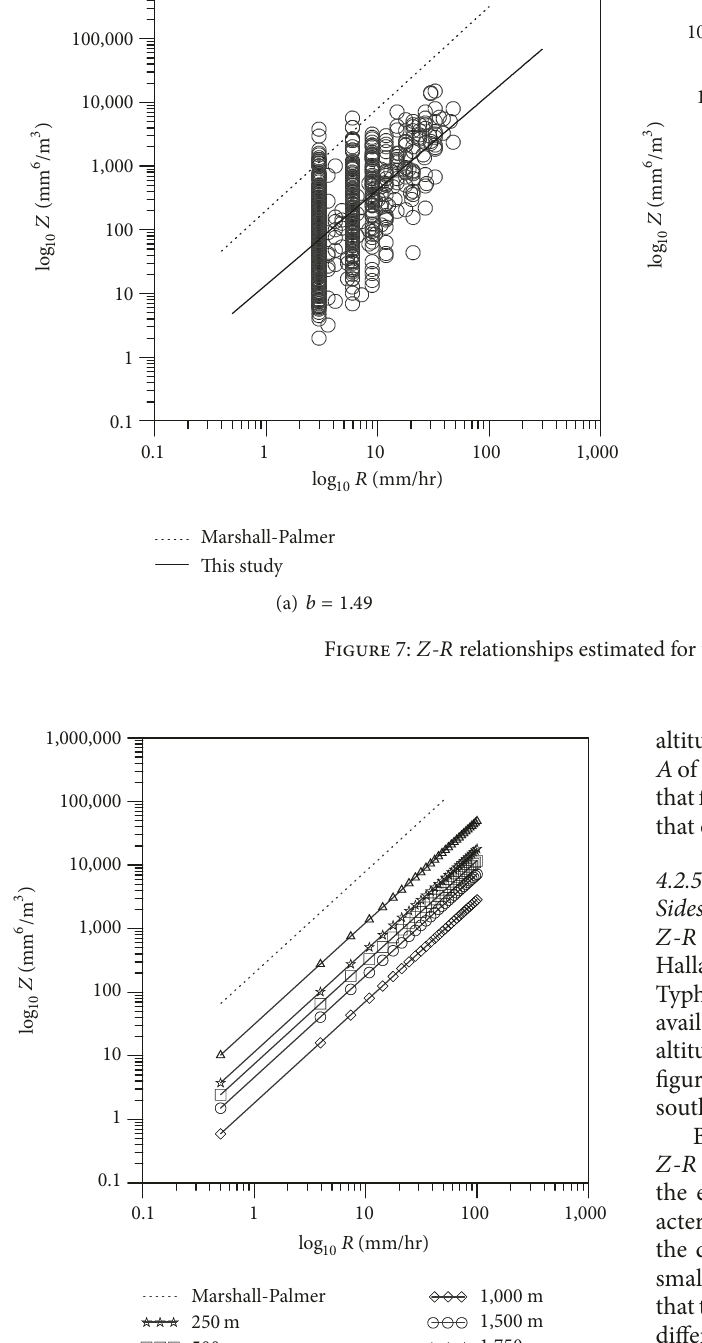
their DSD distributions can be used to estimate the parameter 𝐴 of the 𝑍 - 𝑅 relationship [16]. As the DSD distributions are all very similar to the exponential distribution, their decay patterns can be used to compare the parameter 𝐴 of the 𝑍 - 𝑅 relationship. For example, at the altitude 200 m, the DSD distribution shows a fast decay pattern but a slow one for